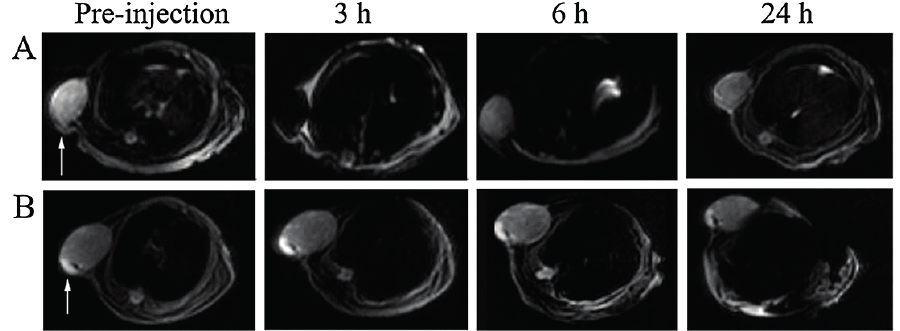
Figure 2. T2-weighted MRI images of xenograft-bearing nude mice injected with VEGF165-aptamer-USPIO probe ( A ) and USPIO nanoparticles only ( B ) from tail vein at a dosage of 9.08nmol/kg body weight. Arrows point to tumor xenografts. Reprinted from [117] with permission from John Wiley and Sons, copyright